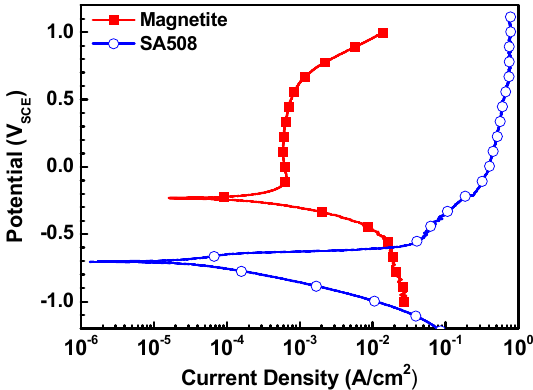
Figure 5. Polarization curves of SA508 and magnetite electrodes in 10% EDTA-based chemical cleaning solution at 93 °C. Table 2. Electrochemical corrosion parameters of SA508 and magnetite in 10% EDTA solution at 93 °C.